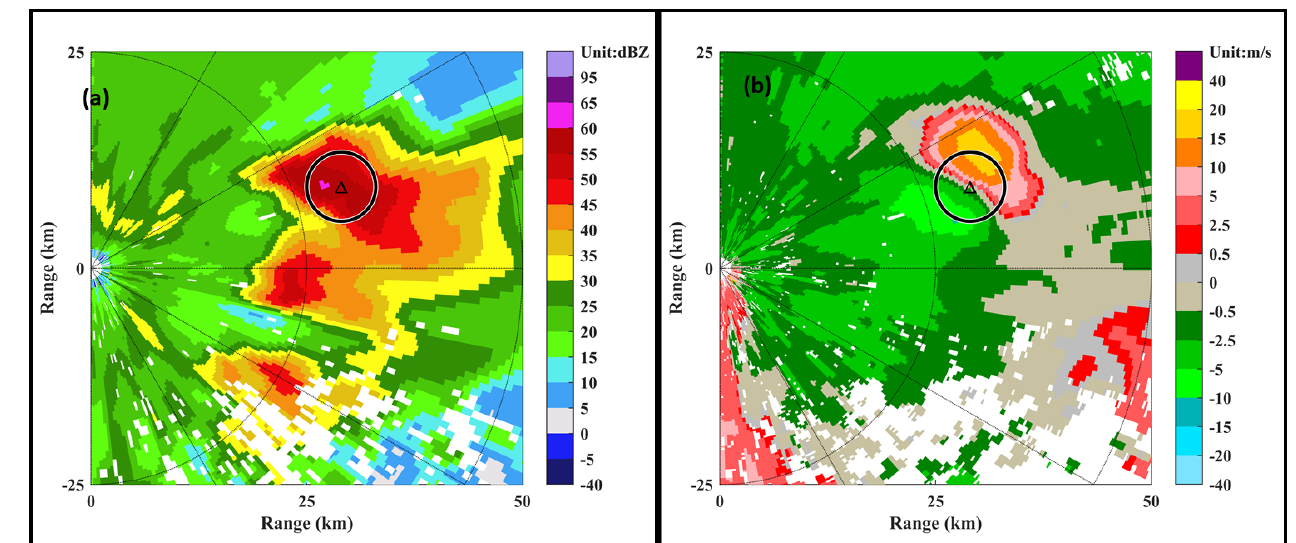
Figure 14 Figure 14. Recognition result of the downburst area and center. ( a ) Downburst area as well as center position on reflectivity PPI, and ( b ) downburst area and center position on radial velocity